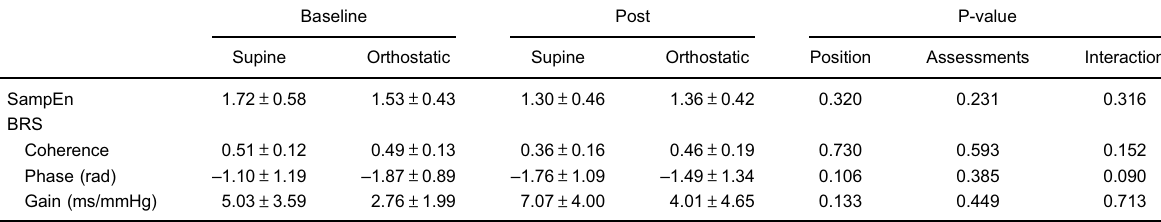
SampEn BRS Coherence